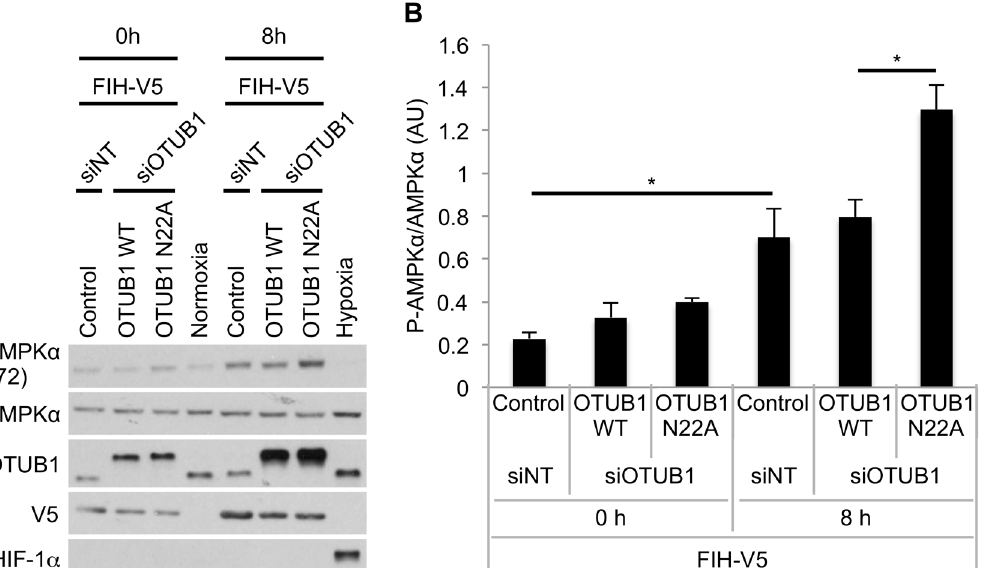
Fig 5. Mutation of the OTUB1 N22 hydroxylation site impacts on AMPK α phosphorylation in response to glucose, pyruvate, and glutamine starvation. (A) HEK293 cells were transfected with either siNT or siOTUB1 for 24 h prior to transfection with pFIH-V5 and either empty vector control, pFLAG-OTUB1 WT or pFLAG-OTUB1 N22A for additional 24 h. Normal culture media was changed to media without glucose, pyruvate and glutamine and the levels of phosphorylation of AMPK α were analyzed at the indicated time points. For the exposure to hypoxia, cells were incubated in 1% O 2 (normoxia: 21% O 2 ) for the indicated time point. (B) Densitometric analysis of P-AMPK α levels at 0 h and 8 h. Data was normalized to total AMPK α . Data is presented as mean + standard error of the mean (SEM) of n = 3 independent experiments. * p < 0.05 by one-way ANOVA followed by Tukey post test. The underlying data of panel B can be found in S1